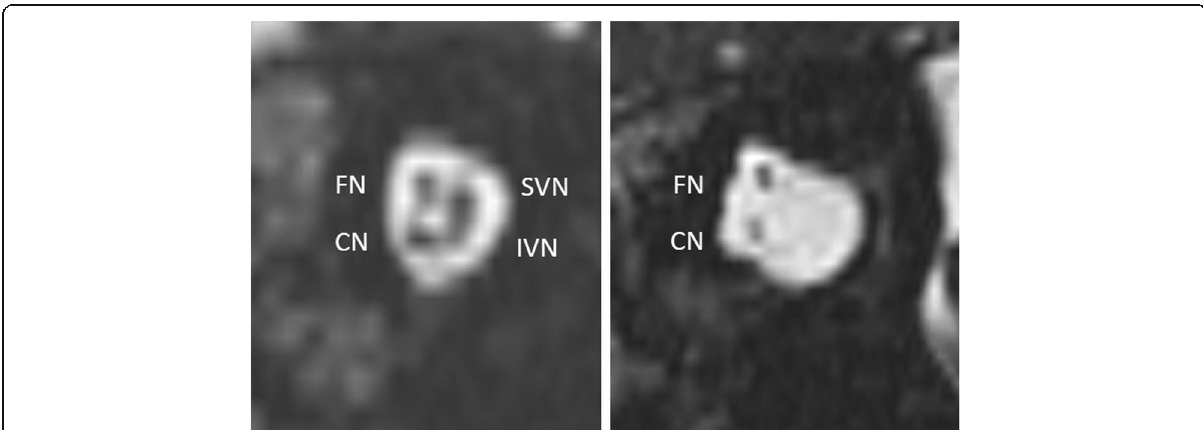
Fig. 6 A 57-year-old female patient with unilateral SNHL from birth. MRI 3D-CISS parasagittal image of the internal auditory canal shows regular facial nerve (FN), cochlear nerve (CN), superior vestibular nerve (SVN), and inferior vestibular nerve on the healthy side (left image) and missing SVN and IVN, as well as a hypoplastic CN on the diseased side (right image)